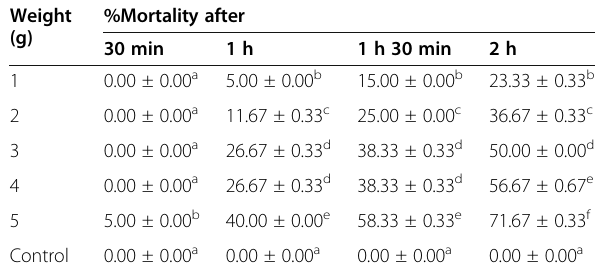
Table 2 Fumigant toxicity of root bark powder of Petiveria alliacea on the mortality of adult Culex